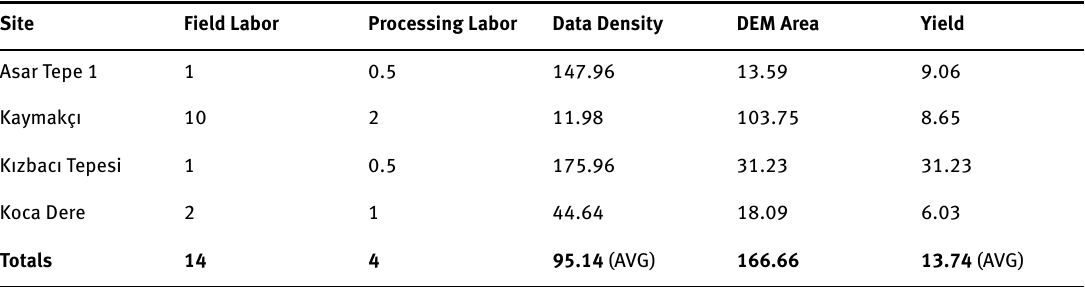
Table 2: Sites surveyed in 2013 with UAVP, showing average field and processing labor (person-days), average data densities (points/m 2 ), areas of valid DEM produced (ha), and yield (ha/person-day).